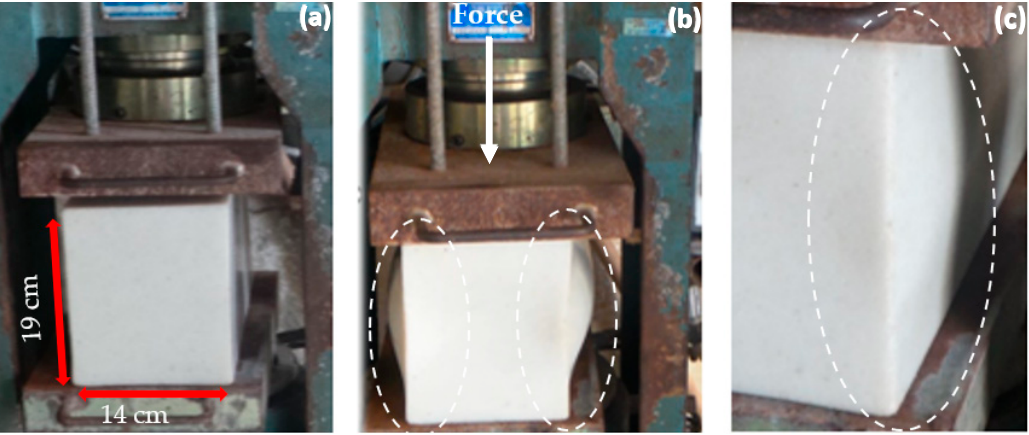
Figure 7. Compression strength test: ( a ) the block at the beginning of the test; ( b ) the block receiving a load and suffering a local elastic deformation on the sides of the block and ( c ) the block returning to its initial shape after the removal of the load applied on it.